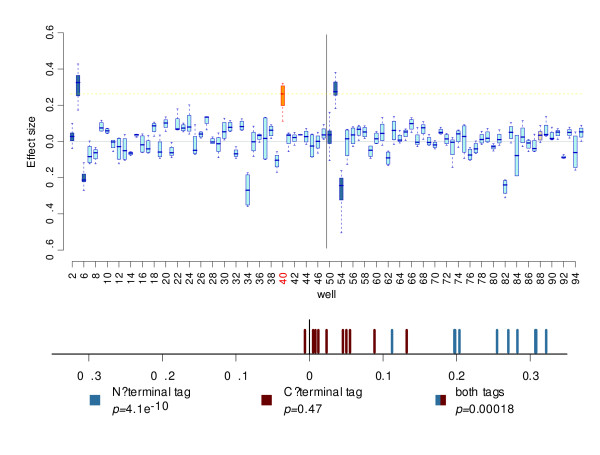
Interactive box plot of effect sizes from replicate experiments for a 96-well plate. Proteins showing consistently high or low effect sizes can easily be identified. By clicking on the individual boxes in the upper panel, a drill-down to the underlying data is provided in the lower panel, which shows the individual measurement values for both fluorescence tags as vertical bars along the x-axis. In this example, only the expression of the amino-terminally tagged protein results in significantly elevated effect sizes.